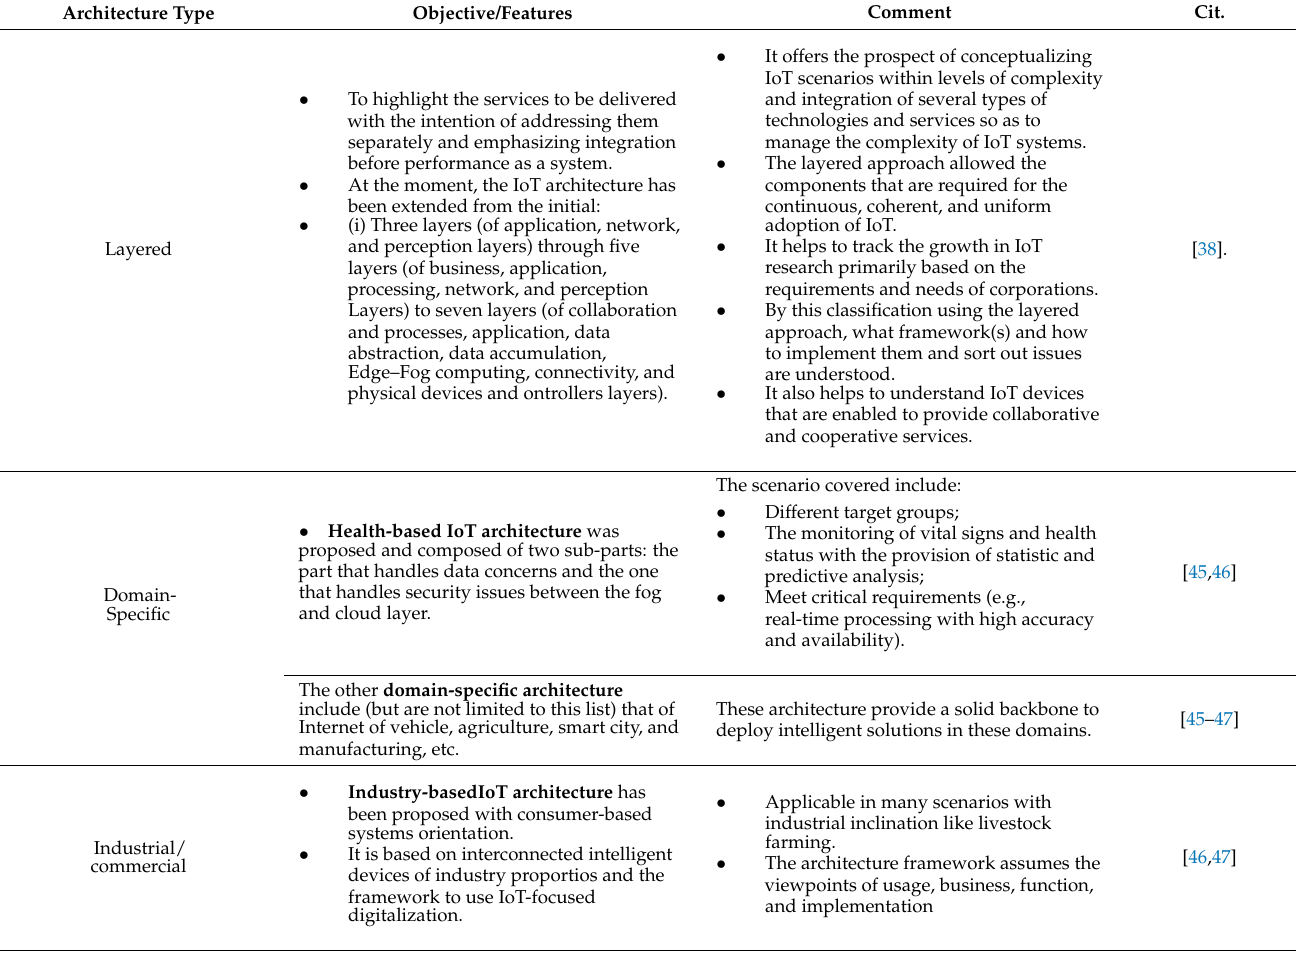
Table 1. A summarized comparison of IoT architecture based on its layered, domain-specific, and industrial orientation. Architecture